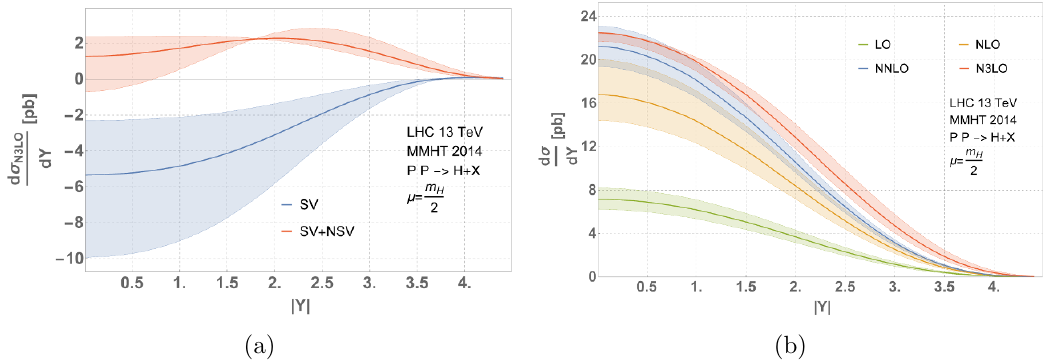
Figure 8. The left plot shows the contribution of the N 3 LO partonic cross section to the absolute rapidity distribution of the Higgs boson approximated by including the (cid:12)rst (blue) an by including the (cid:12)rst and second (red) term in the threshold expansion. The right plot shows the rapidity distribution of the Higgs boson computed through di(cid:11)erent orders in perturbation theory. N 3 LO contributions were approximated by performing a threshold expansion through the second